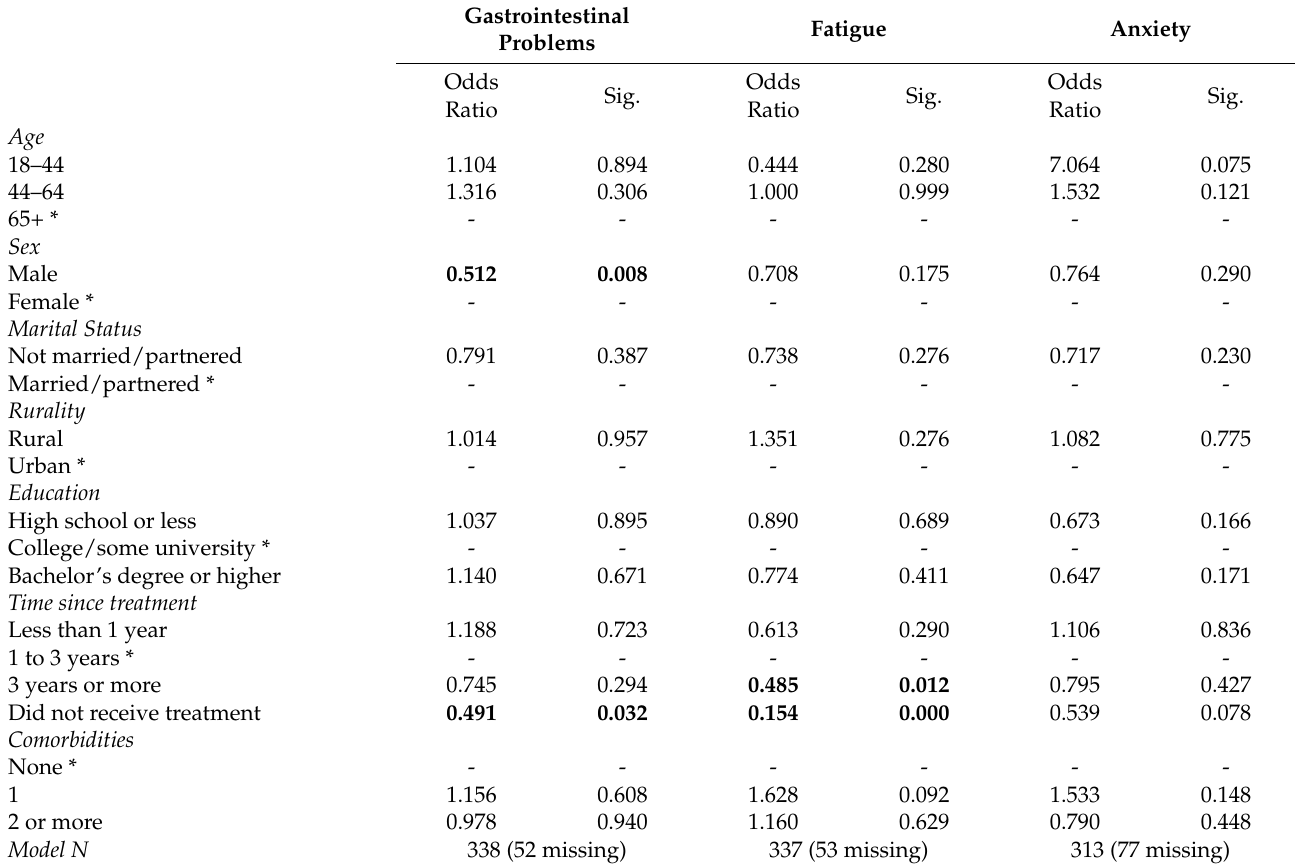
Table 8. Odds ratios from binary logistic regressions for gastrointestinal patients.